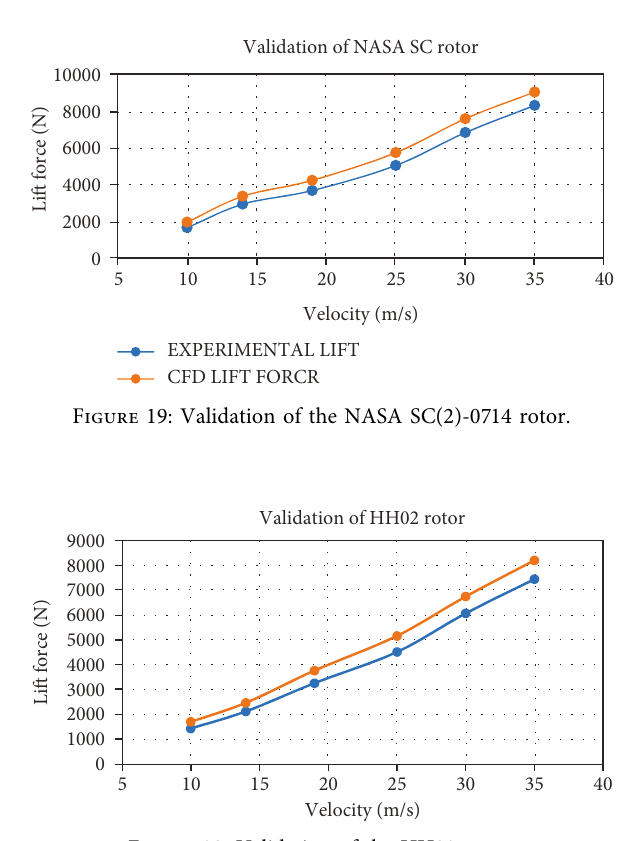
Figure 20: Validation of the HH02